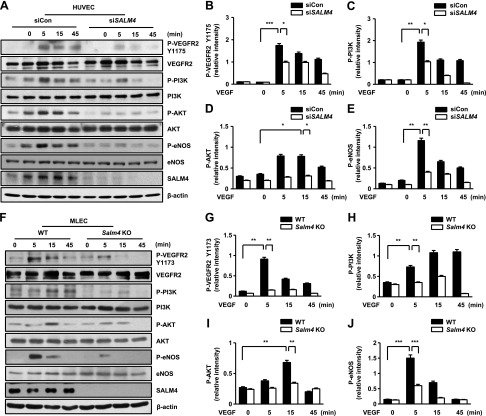
SALM4 regulates VEGFR2 phosphorylation at Y1175 (Y1173 in mice) and downstream signaling in HUVECs and MLECs stimulated with VEGF-A. A) Effects of SALM4 knockdown on signaling pathways induced by VEGF-A (20 ng/ml) in HUVECs. B–E) Blots were assessed using ImageJ software; n = 3 independent experiments. F) Effects of Salm4 KO on signaling pathways induced by VEGF-A (20 ng/ml) in MLECs. G–J) Quantification of blots using ImageJ software; n = 3 independent experiments. Error bars represent means ± sd. Blots incubated with phospho-specific antibodies were probed only once from the different gels. Other blots were stripped and reprobed. P-, phosphorylated. *P < 0.05, **P < 0.01, ***P < 0.001 by paired, 2-tailed Student’s t test.